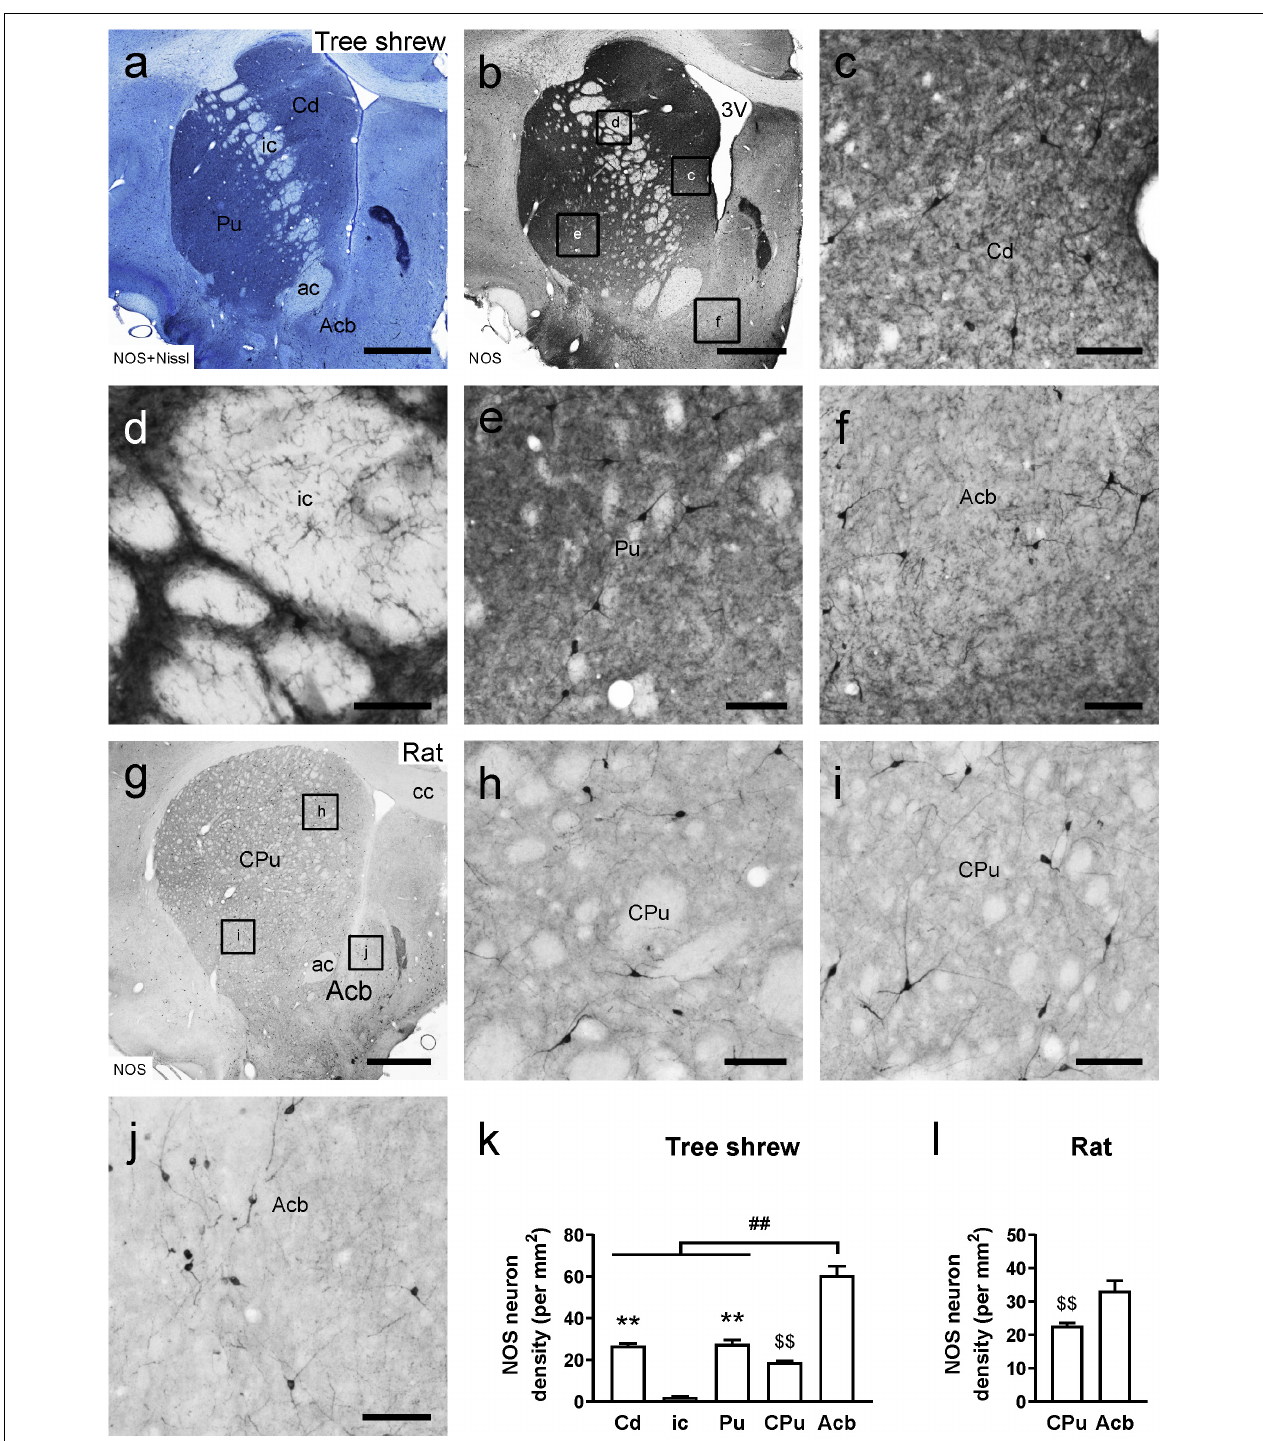
FIGURE 2 | Comparison of nitric oxide synthase (NOS)-ir staining in the striatum of the tree shrew and rat brains. (a) Photomicrograph showing Nissl staining (blue) following NOS immunoperoxidase labeling (black) in a coronal section of the tree shrew striatum. (b) Low-magnification photomicrograph illustrating NOS-ir staining in an adjacent section of the tree shrew striatum. (c–f) High-magnification image of NOS immunoreactivity in the caudate nucleus (Cd), internal capsule (ic), putamen (Pu), and accumbens nucleus (Acb) of the striatum (boxed area in b). (g) Low-magnification photomicrograph illustrating NOS immunoreactivity in an equivalent section of the rat striatum. (h–j) High-magnification image of NOS immunoreactivity in the caudate putamen (CPu) and Acb of the rat striatum (boxed area in g ). (k)